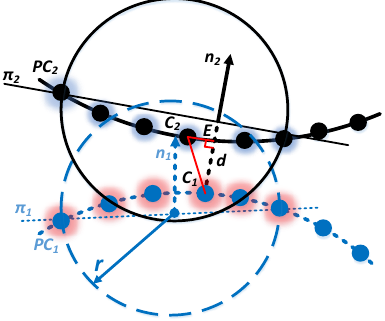
Figure 10. Definition of the distance and angle error.